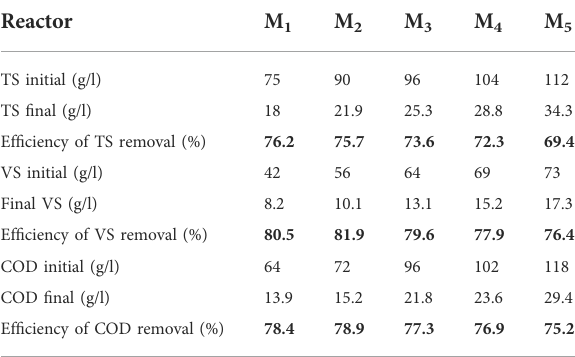
TABLE 3 TS, VS, and COD removal ef fi ciency with different biochar doses at mesophilic temperature.